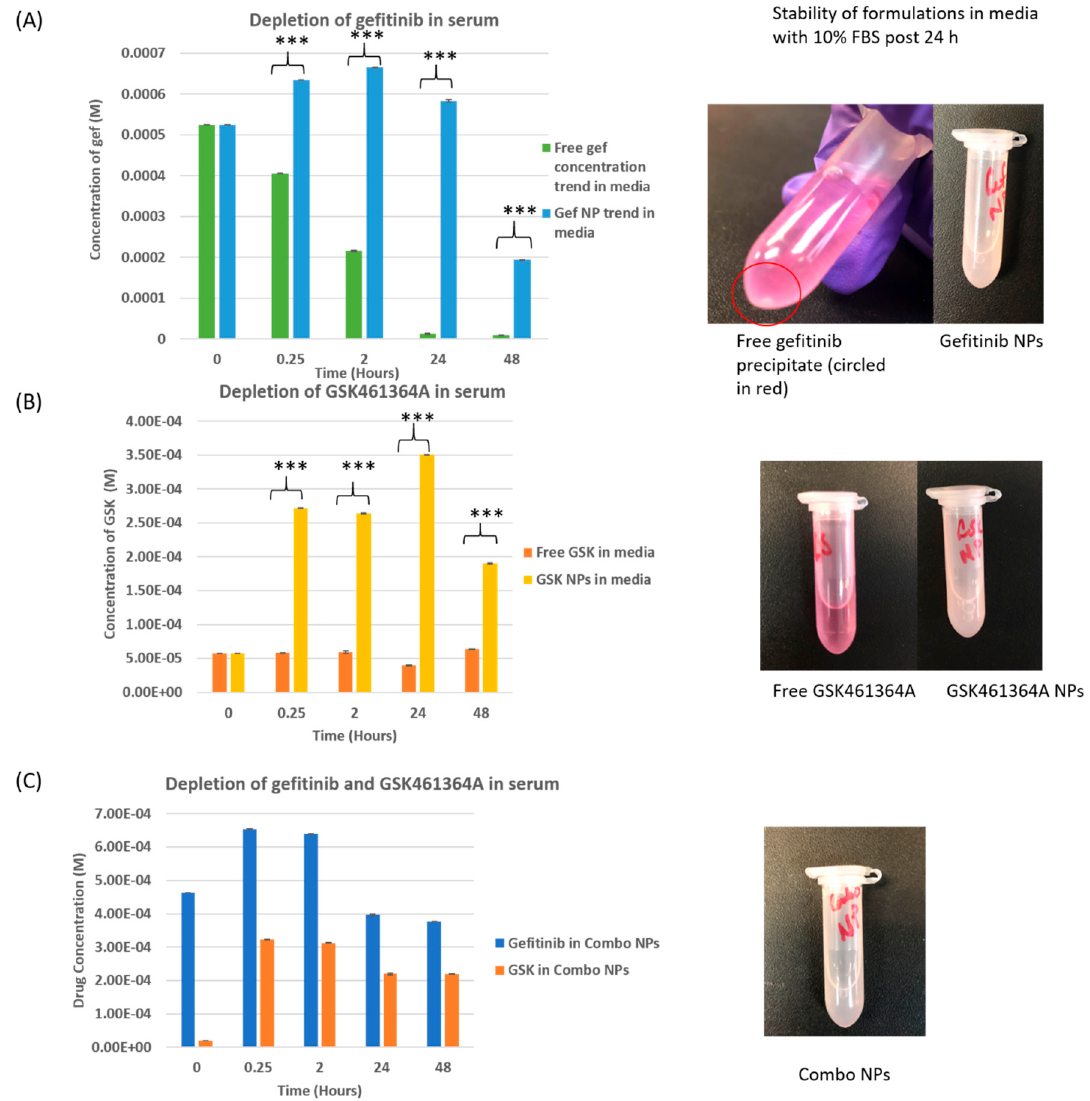
Figure 4. In vitro drug degradation of free gef, gef NPs, free GSK461364A, GSK461364A NPs, and combo NPs at 37 °C in media containing 10% FBS over 48 h. *** p < 0.001.